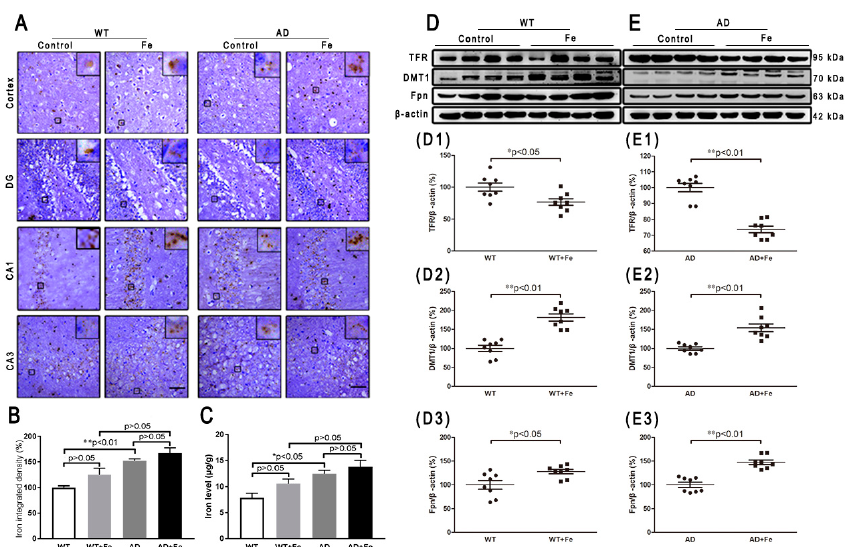
Figure 1. Effect of high dietary iron on iron and iron-transport-related proteins in the mouse brain. ( A ) Perl’s diaminobenzidine (DAB) iron staining showed that high dietary iron (HDI) could increase the number of iron-positive cells in the cortex and hippocampal region of wild-type (WT) and APP/PS1 mice. ( B ) Quantitative analyses of Perl’s-DAB iron staining. Scale bar = 50 µ m. ( C ) The results of iron atomic absorption spectroscopy (AAS). ( D , E ) Western blot analysis of transferrin receptor (TFR), divalent metal transporter 1 (DMT1) and ferroportin (Fpn). ( D1 – D3 , E1 – E3 ) Quantitative analyses of Western blot for TFR, DMT1 and Fpn. β -actin was used as an internal control. All results are presented